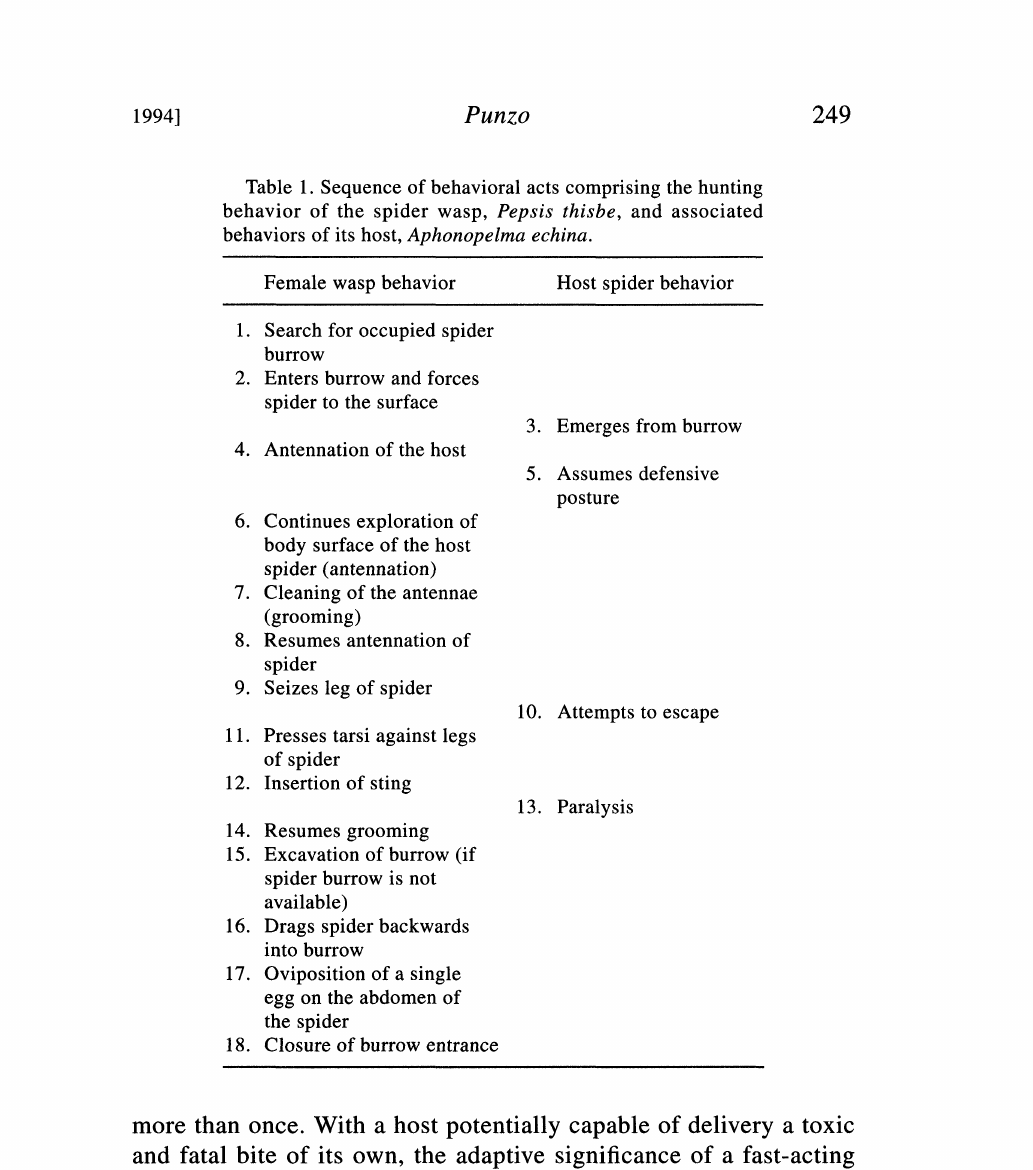
Table 1. Sequence of behavioral acts comprising the hunting behavior of the spider wasp, Pepsis thisbe, and associated behaviors of its host, Aphonopelma